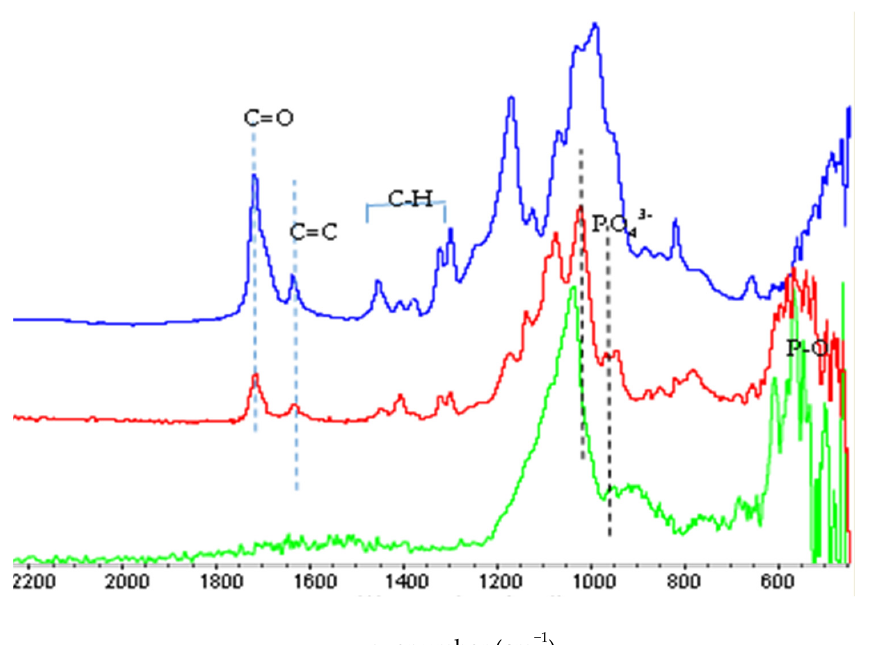
Figure 1. FTIR spectra of Bis 2-(methacryloyloxy) ethyl phosphate (Bis 2) monomer (blue line], methacrylate functionalized calcium phosphate (MCP) (red line), and MCP annealed at 600 ◦ C for 4 h (green line). Both Bis-2 and MCP show the characteristic absorption peak of the methacrylate group (1720 cm − 1 and 1638 cm − 1 ) and other absorption peaks originated from C-O and P-O groups (see text). The annealed MCP showed only absorption peaks characteristic of P-O groups, and no peaks related to the organic functional C-O groups.